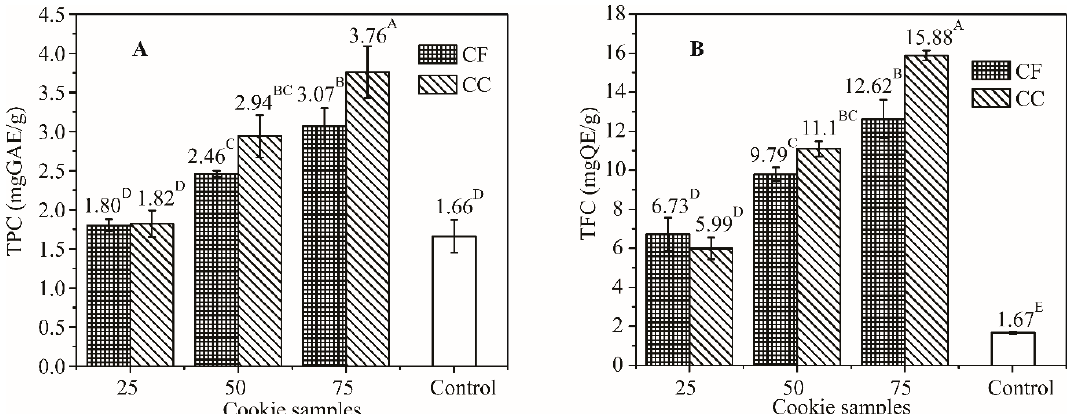
Figure 1. Increase of the total polyphenolic (TPC; A ) and flavonoid content (TFC; B ) of cookies in relation to the percentage of wheat flour substituted with coarse and fine APF (different superscripts indicate significant differences of means, according to Tukey’s HSD (honestly significant difference) test ( p < 0.05)).